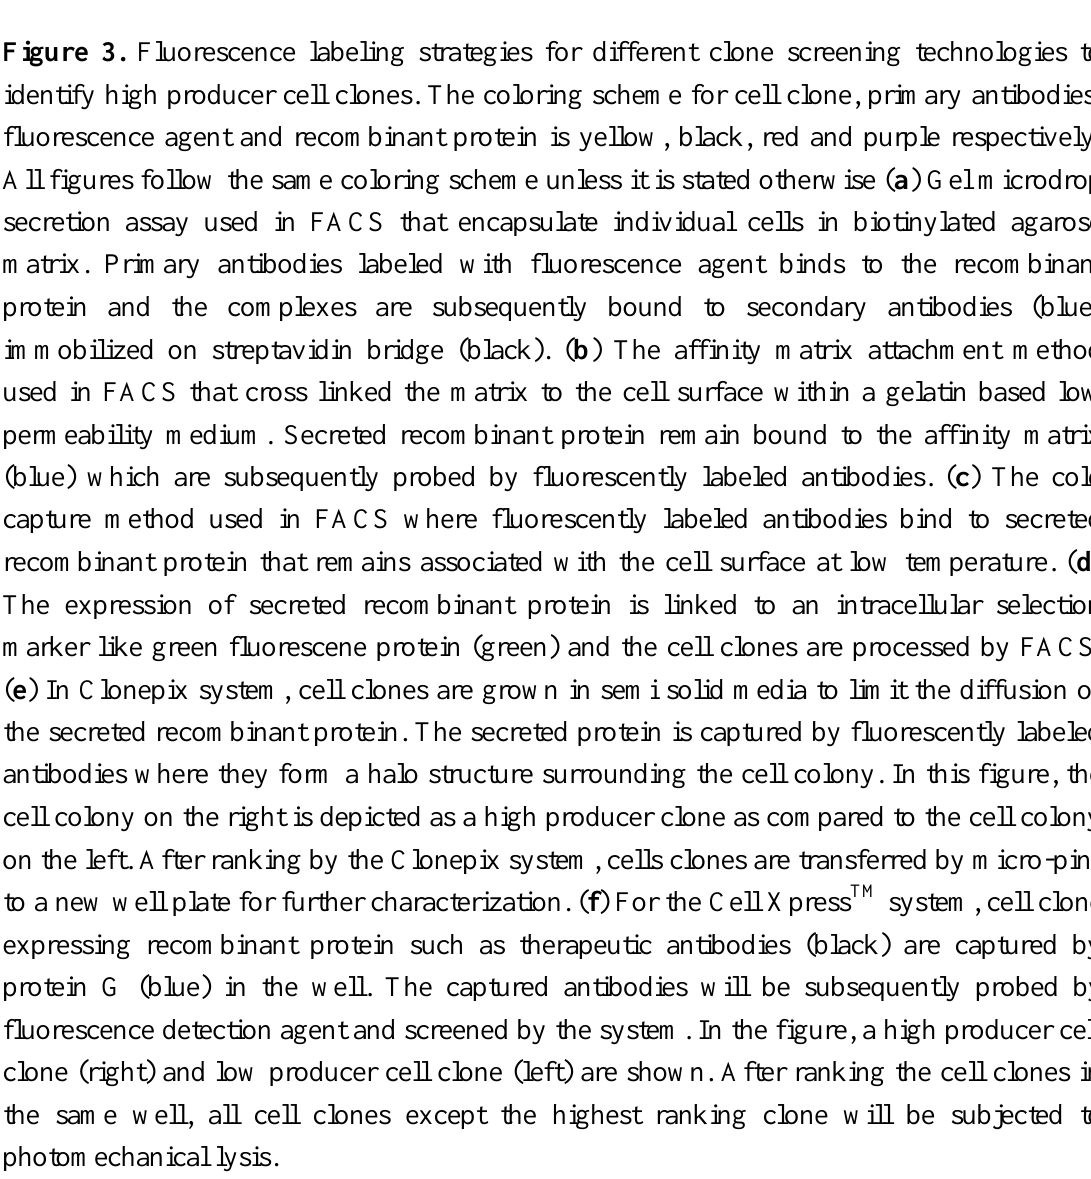
Figure 3. Fluorescence labeling strategies for different clone screening technologies to identify high producer cell clones. The coloring scheme for cell clone, primary antibodies, fluorescence agent and recombinant protein is yellow, black, red and purple respectively. All figures follow the same coloring scheme unless it is stated otherwise ( a ) Gel microdrop secretion assay used in FACS that encapsulate individual cells in biotinylated agarose matrix. Primary antibodies labeled with fluorescence agent binds to the recombinant protein and the complexes are subsequently bound to secondary antibodies (blue) immobilized on streptavidin bridge (black). ( b ) The affinity matrix attachment method used in FACS that cross linked the matrix to the cell surface within a gelatin based low permeability medium. Secreted recombinant protein remain bound to the affinity matrix (blue) which are subsequently probed by fluorescently labeled antibodies. ( c ) The cold capture method used in FACS where fluorescently labeled antibodies bind to secreted recombinant protein that remains associated with the cell surface at low temperature. ( d ) The expression of secreted recombinant protein is linked to an intracellular selection marker like green fluorescene protein (green) and the cell clones are processed by FACS. ( e ) In Clonepix system, cell clones are grown in semi solid media to limit the diffusion of the secreted recombinant protein. The secreted protein is captured by fluorescently labeled antibodies where they form a halo structure surrounding the cell colony. In this figure, the cell colony on the right is depicted as a high producer clone as compared to the cell colony on the left. After ranking by the Clonepix system, cells clones are transferred by micro-pins to a new well plate for further characterization. ( f ) For the Cell Xpress TM system, cell clone expressing recombinant protein such as therapeutic antibodies (black) are captured by protein G (blue) in the well. The captured antibodies will be subsequently probed by fluorescence detection agent and screened by the system. In the figure, a high producer cell clone (right) and low producer cell clone (left) are shown. After ranking the cell clones in the same well, all cell clones except the highest ranking clone will be subjected to photomechanical